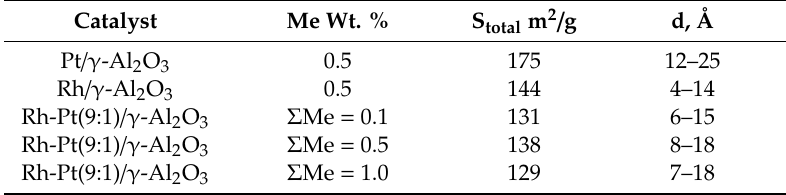
Table 4. Characteristics of the prepared supported catalysts.